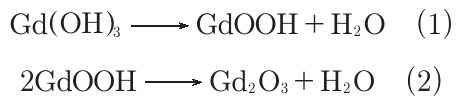
Figure 3: FE-SEM images of (a) as-prepared Gd(OH) the MAH treatment (b) Gd(OH)